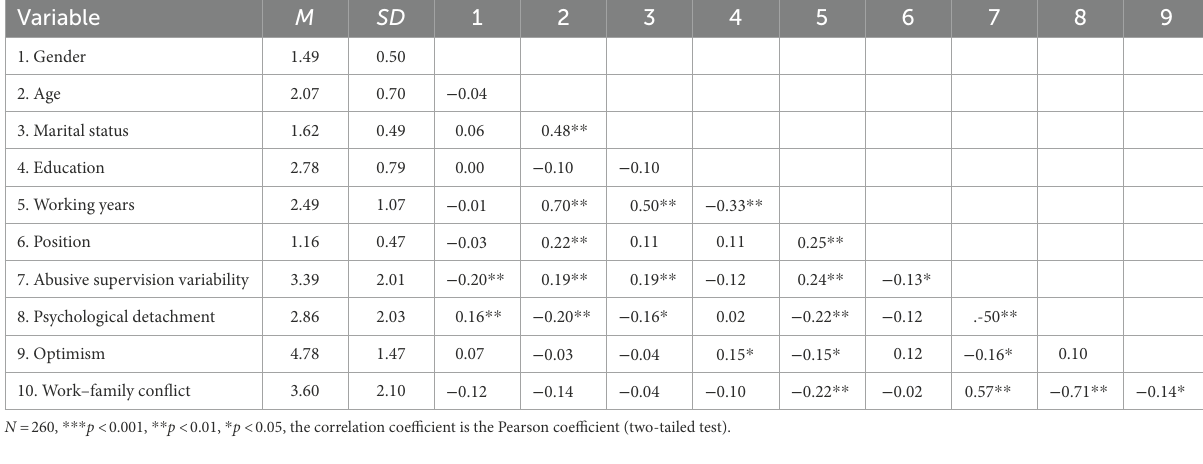
TABLE 2 Confirmatory factor analysis